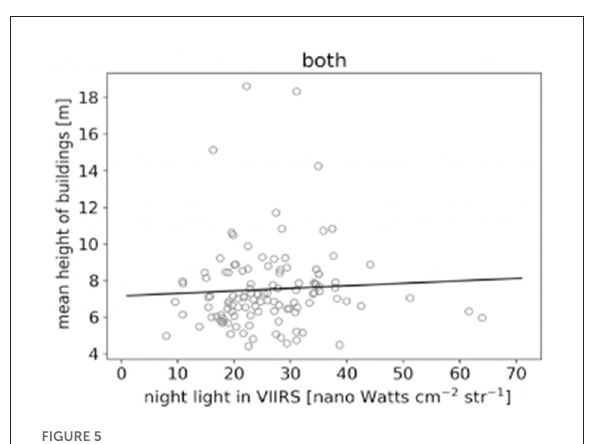
FIGURE5 Scatter plot of the night light and building height for land use ratio of 90% and above.